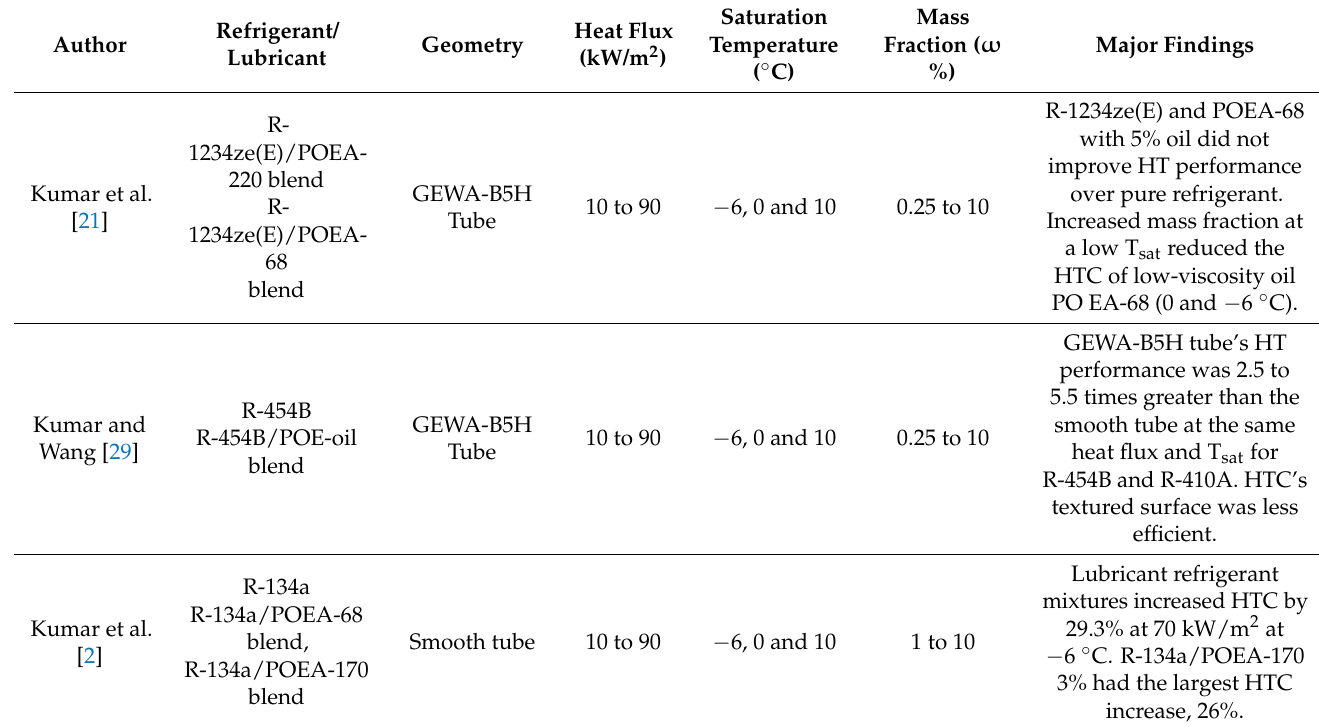
Figure 6. Influence of HTCs and heat flux on R-134a, R-1234ze(Z), R-245fa, and R-1234ze(E) [25]. Table 2. Experimental conditions, dimensions and specifications of smooth and enhanced tubes.